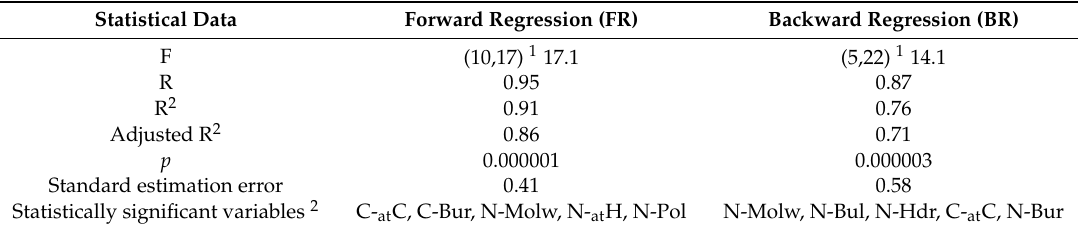
Table 1. Statistical summary of forward and backward regression (FR and BR, respectively) made for the angiotensin converting enzyme (ACE)-inhibiting/bitter dipeptide dataset ( α = 0.01).